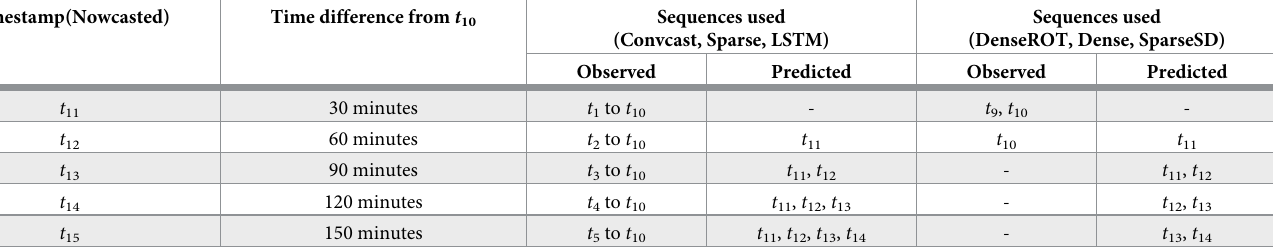
Table 4. Dataset sequence for nowcasting up to 150